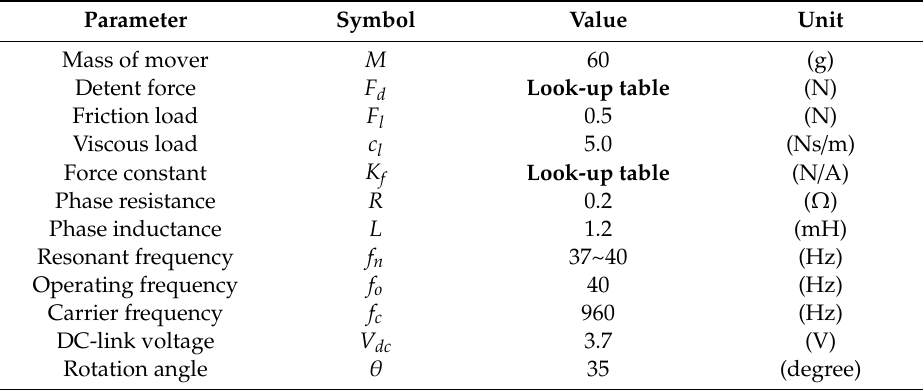
Table 1. Simulation condition.